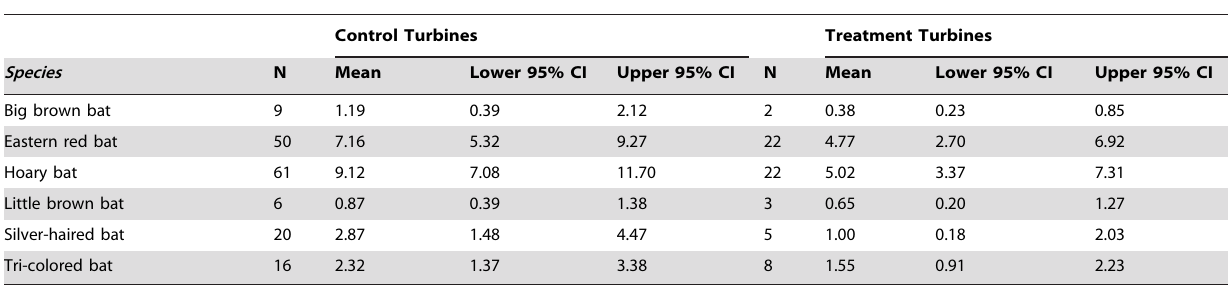
Table 6. Estimated bat fatalities/turbine (mean and 95% confidence intervals [CI]) for each species of bat per turbine, adjusted for searcher efficiency, carcass removal, and area, at control and treatment turbines at the Locust Ridge Wind Project in Columbia and Schuylkill Counties, Pennsylvania, 31 July–9 October